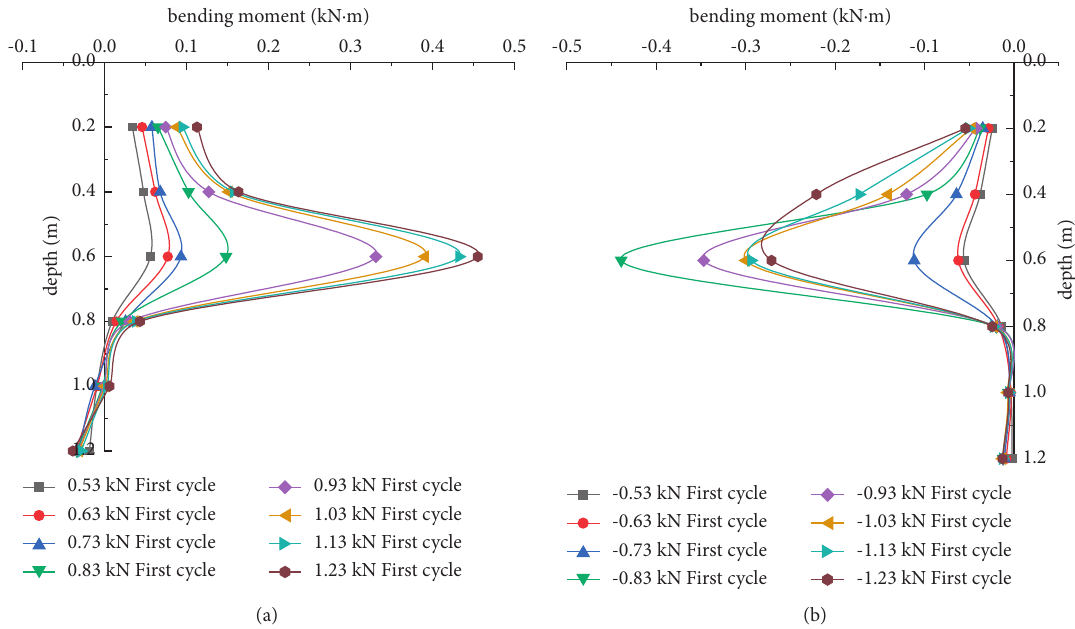
Figure 8: Bending moment distribution diagram of pile body in LK2. (a) In forward loading process. (b) In reverse loading